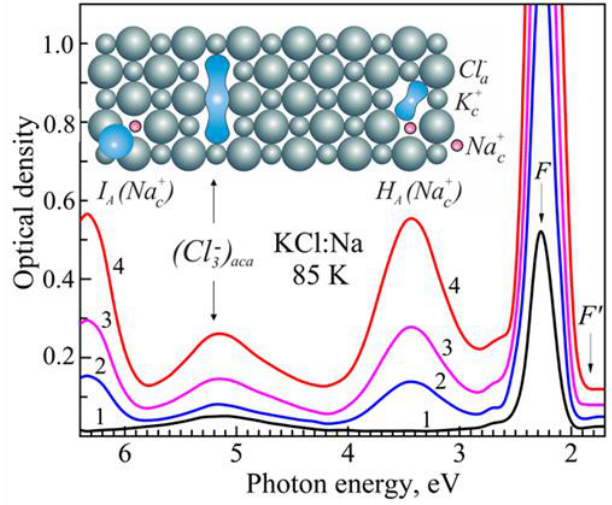
Figure 1. Absorption spectra of radiation defects measured for freshly grown KCl (curve 1) and KCl:Na single crystals (curve 2—10 ppm of Na + ; curve 3—100 ppm; and curve 4—1000 ppm) after isodose X-irradiation at 85 K (20 mA, 45 kV, W-anticathode, 3 h). All spectra were measured at 85 K. The insert shows the models of some defects (for details, see the text).